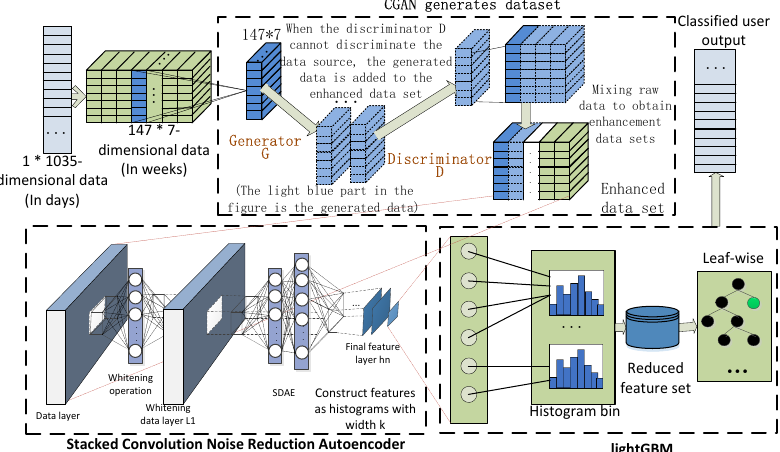
Figure 1. Electricity stealing model based on CWGAN's SCDAE-LightGBM model.